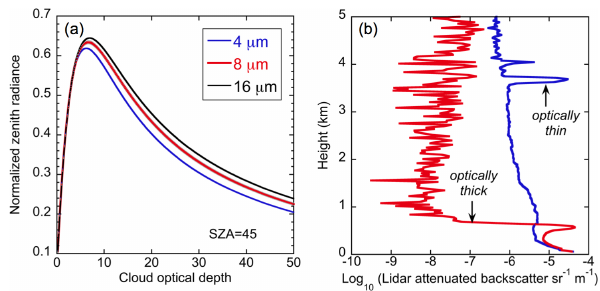
Figure 1. (a) Plot of calibrated solar background light in lidar mea- surements versus cloud optical depth at 523nm wavelength and solar zenith angle (SZA) of 45 ◦ for cloud effective radius of 4, 8 and 16µm. (b) Vertical profiles of logarithm (with base 10) li- dar attenuated backscatter signals measured on 15 June 2007 at the ARM Oklahoma site at 19:00UTC for optically thick clouds, and at 23:30UTC for optically thin